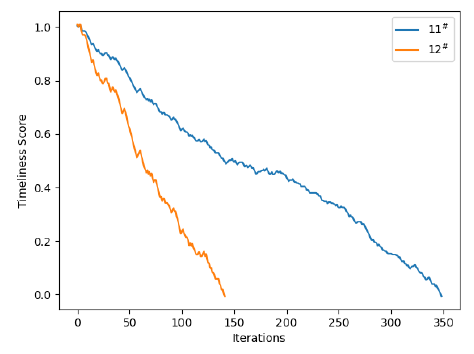
Figure 6. The trend of timeliness score converging to 0.